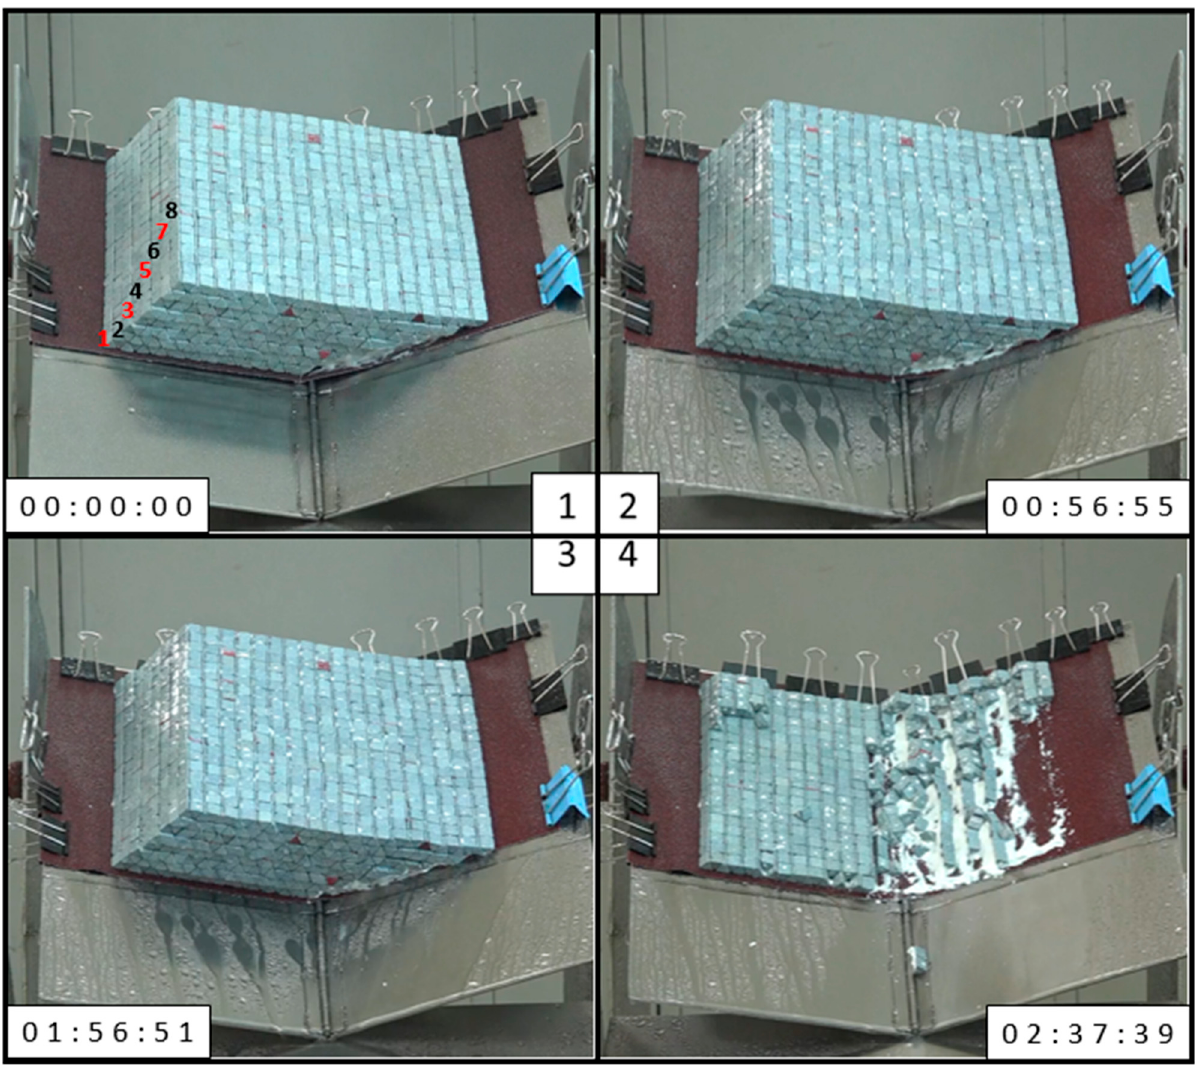
Figure 9. Physical test process of Model D ( i a = 40° and ω 1 = ω 2 = 75°). The primary conditions of Model E were i a = 70° and ω 1 = ω 2 = 25°, and the duration of the test was 3 h 24 min 03 s (Figure 10). At the first stage (the initial deformation stage; 00:00:00–01:44:39), the model softened because of rainfall infiltration, and the greater in- formation was observed after 20 min of rainfall. The weak planes in the oblique slope were inclined towards the right plate, and, as a result, soon after the surface water had infil- trated the model, the surface layer at the slope toe on the right plate (locations No. 7–10) showed local collapses and toppling failure. During the second stage (the local rock mass failure stage; 01:44:40–03:14:12), as some of the rock at the slope toe on the right plate collapsed, the rock on the right plate also became unstable, gradually resulting in wedge failure. Approximately 30% of the rock wedge slid and collapsed along the slope, greatly reducing the support below the rock mass on the right plate. Losing its support on the right, the entire rock wedge relied on the rock on the left plate and the intersection line for support. Then, as the duration of surface water infiltration increased, gravity and the weakening of the rock near the left led to gradual leaning and deformation. Subsequently, the rock in the back collapsed and toppled on a large scale along the intersection line, and only 5% of the rock remained on the slope. The duration of the Model F ( i a = 70° and ω 1 = ω 2 = 45°) test was 7 h 49 min 14 s (Figure 11). At the first stage (the initial slope deformation